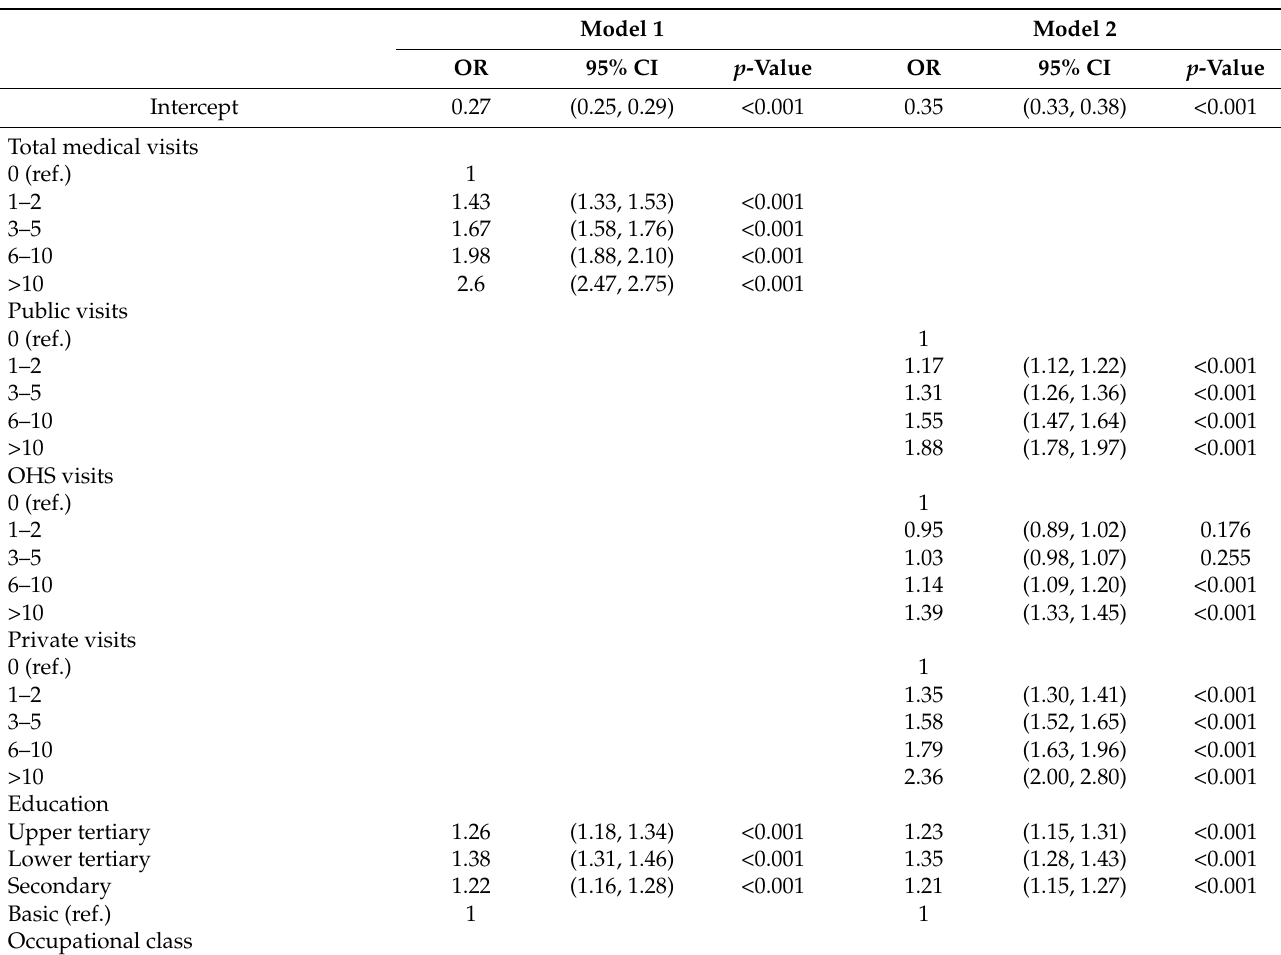
Table A1. Logit odds ratios (OR) and 95% confidence intervals (CI) for having at least one dentist visit. Model